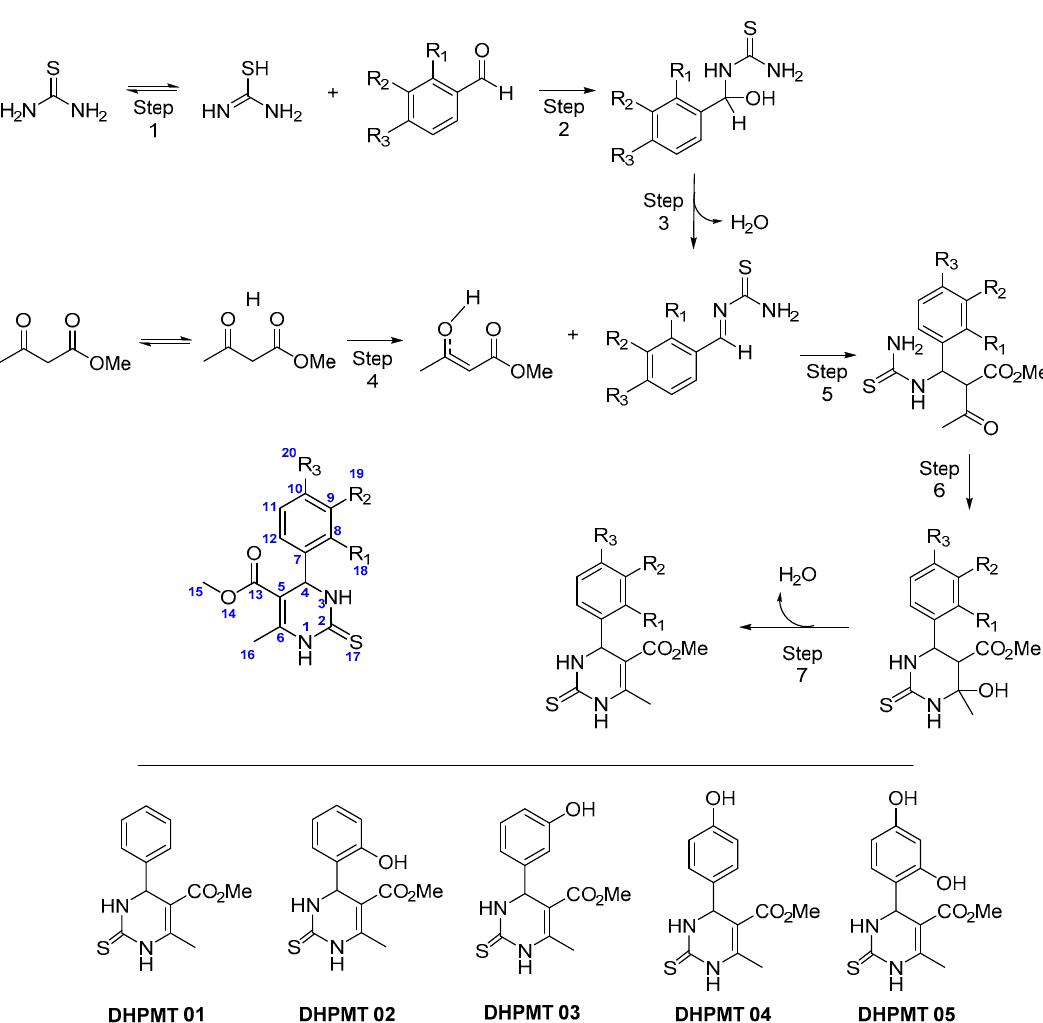
Figure 1. Biginelli pathway reaction for selected aromatic aldehyde, according to iminium route.